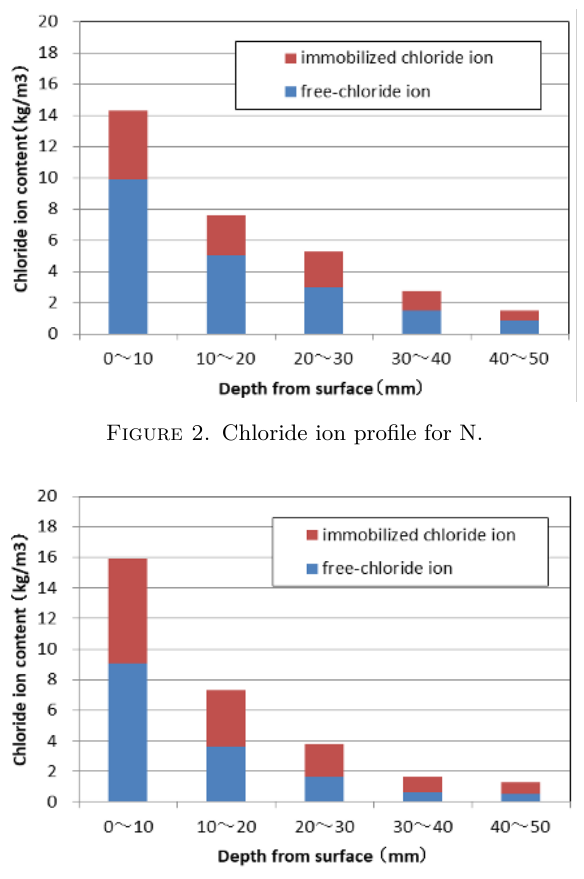
Figure 3. Chloride ion profile for N+CA 2 .